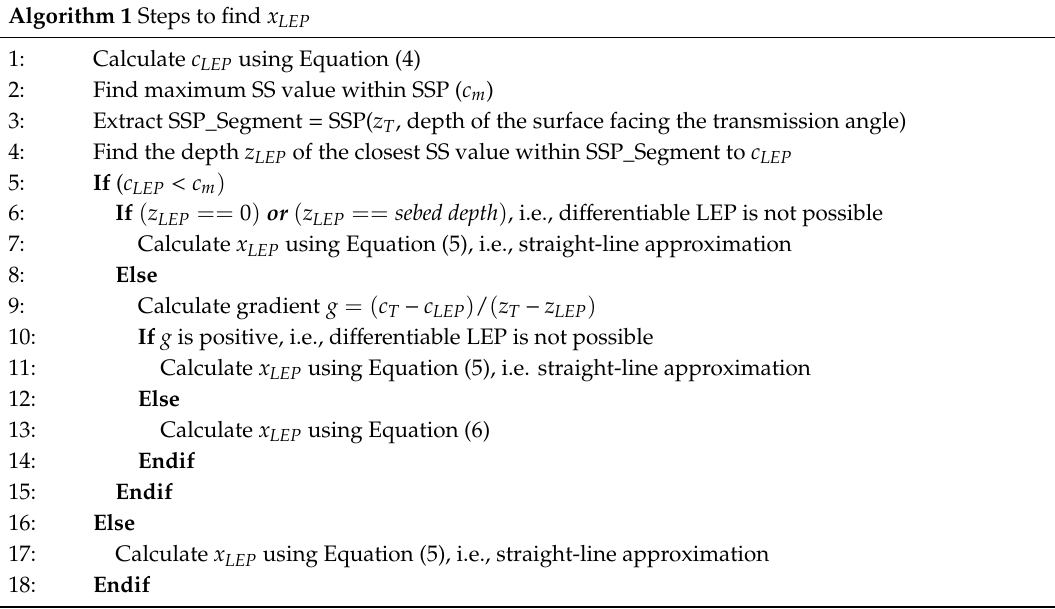
Figure 9. Conceptual figure where the maximum horizontal distance for a given transmission angle is presented.